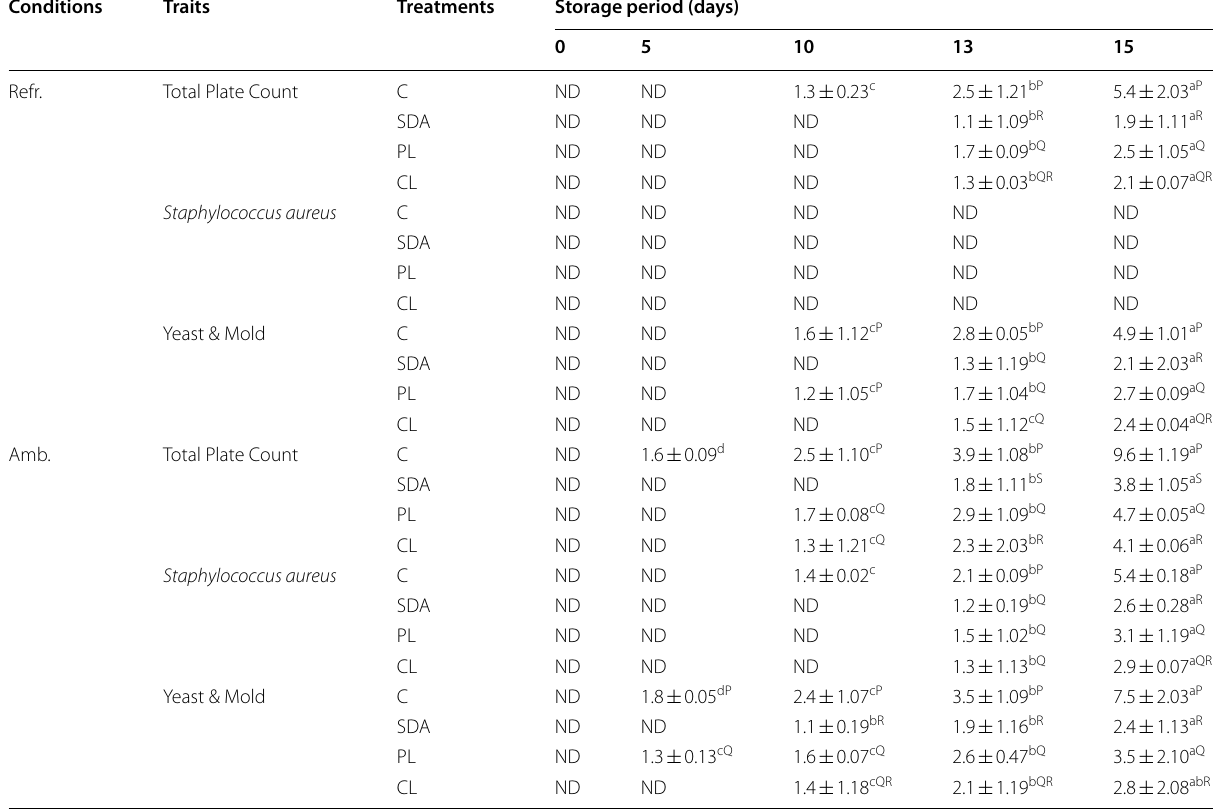
All values are mean standard deviation of three replicates ( n ± Values followed by the same letter in a row and in the column do not differ significantly ( p …’ within a